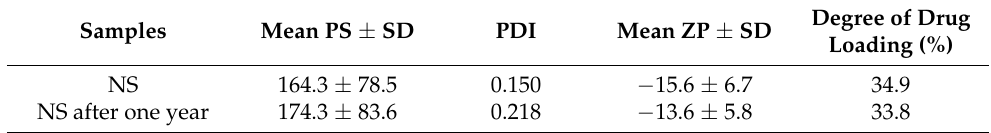
Table 2. Particle size (PS), zeta potential measurement (ZP), and the content of NS after freeze-drying.